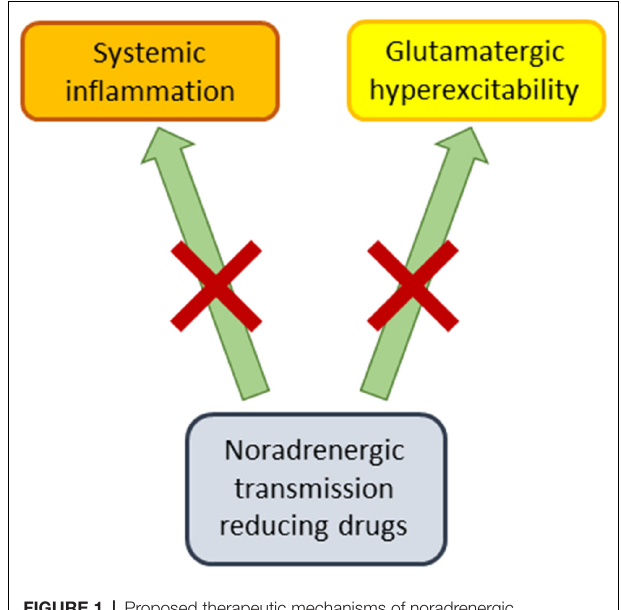
FIGURE 1 | Proposed therapeutic mechanisms of noradrenergic transmission reducing drugs. These pharmacological agents (alpha2 agonists, beta blockers, alpha1 antagonists) may produce antidepressant-like effects by dampening systemic inflammation, while also counteracting glutamatergically-mediated neural